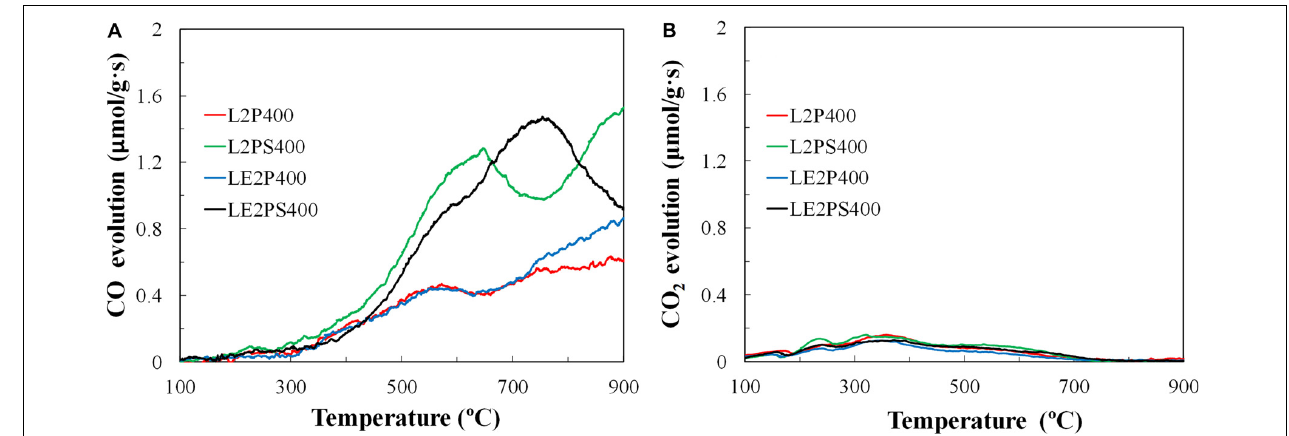
FIGURE 8 | (A) CO and (B) CO 2 evolution of the different activated